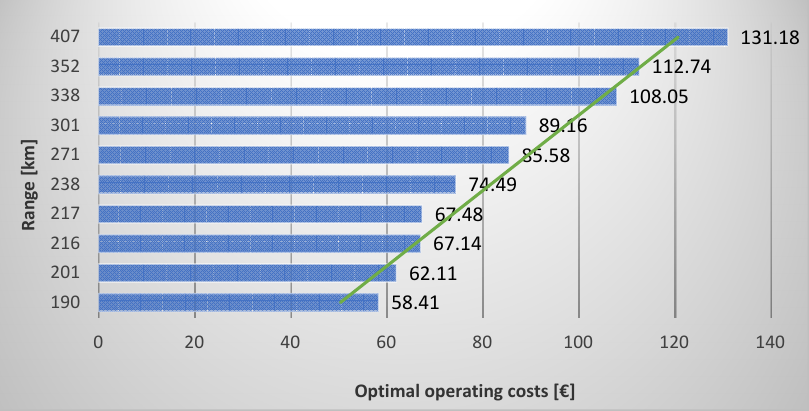
Figure 6. Values of operating costs for individual range distances. Source: Authors. In the case of an aircraft used for training flights around the airport, for takeoff and landing training, the percentage of the hybrid could be higher at the expense of a lower range. This would be more advantageous from the point of view of electric aircraft operation, which would reduce emissions and noise around the airport.